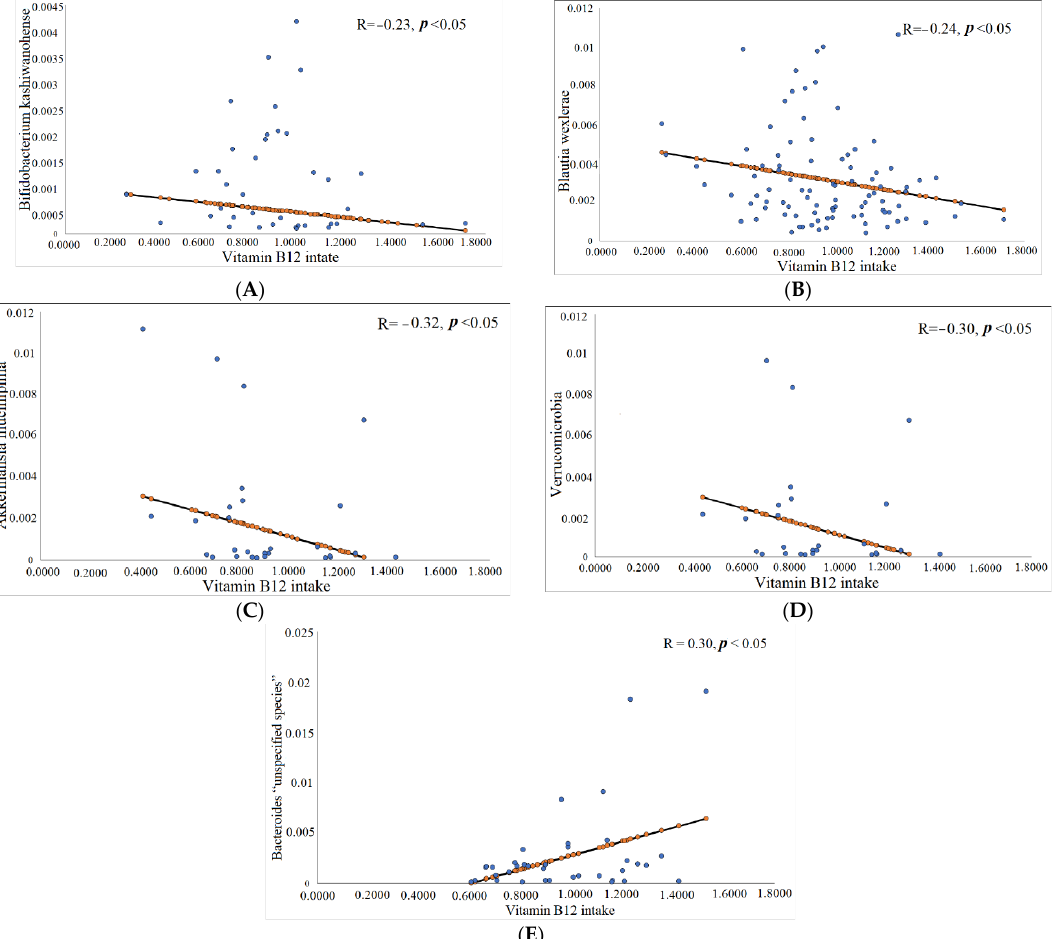
Figure 1. Correlation coefficients between vitamin B12 intake and ( A ) Bifidobacterium kashiwanohense species and ( B ) Blautia wexlerae in total participants. Correlation coefficients between vitamin B12 intake and ( C ) Akkermansia muciniphila species, ( D ) Verrucomicrobia phylum, and ( E ) Bacteroides “unspecified species” in obese participants (cases).